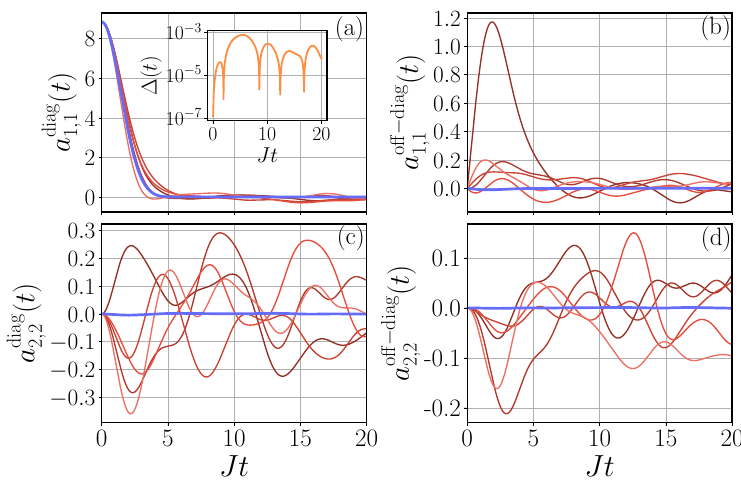
( t ) computed in single disorder realizations (red Figure 1 . Dynamics of the coefficients a ( k ) m k ,m k curves) and in ensemble average (blue curves) for the operator ˆ R . The inset of panel (a) portrays (cid:12) Ei(cid:12) h i hD ˆ E D ˆ the difference ∆( t ) = ( t ) /a diag (0) . Data is for N = 10 at half (cid:12) (cid:12) a diag − E R ( t ) / R (0) (cid:12) E (cid:12) 1 , 1 1 , 1 filling Q = N/ 2 . The ensemble averages are estimated by performing statistical averages over 10000 independent disorder realizations. The terms of size (2 , 2) vanish on average, in agreement with the predicted absence of operator growth. In contrast, there is a finite overlap with the D ˆ E diagonal operator of size (1 , 1) , and the time-evolution matches the full dynamics of , as can R ( t ) be appreciated by the inset of panel (a). Curves for individual realizations show that components with sizes different from (1 , 1) are in general developed throughout the